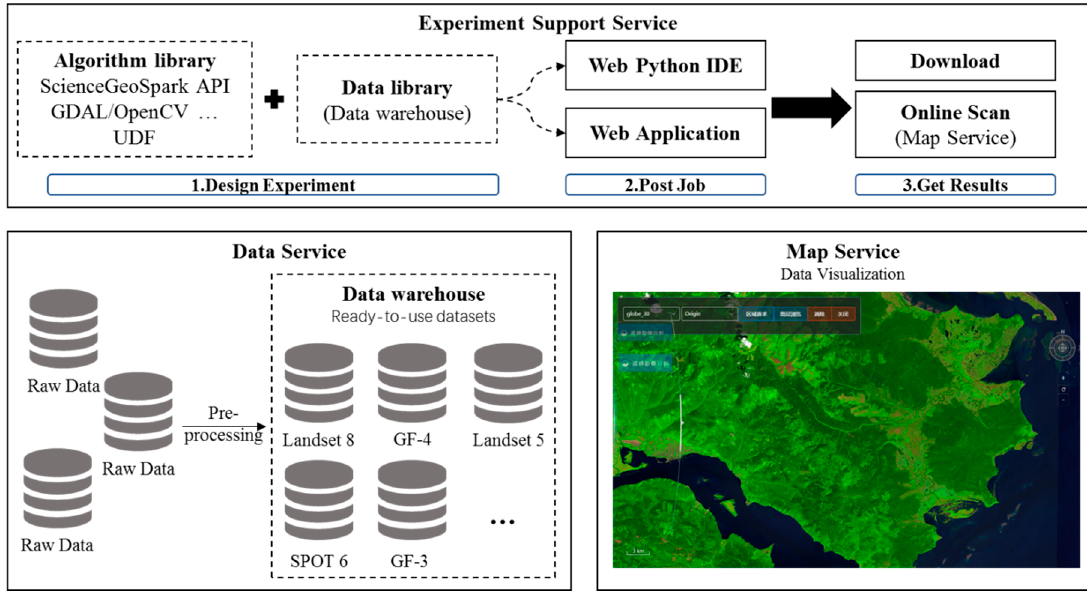
Figure 7. Service modules of ScienceEarth, i.e., experiment support service, data service, and map service.